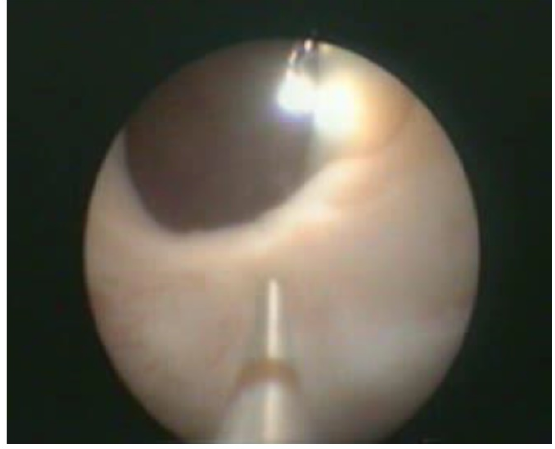
Figure 4. Combined endoscopy to guide each other for optimal localization for bladder neck injection.